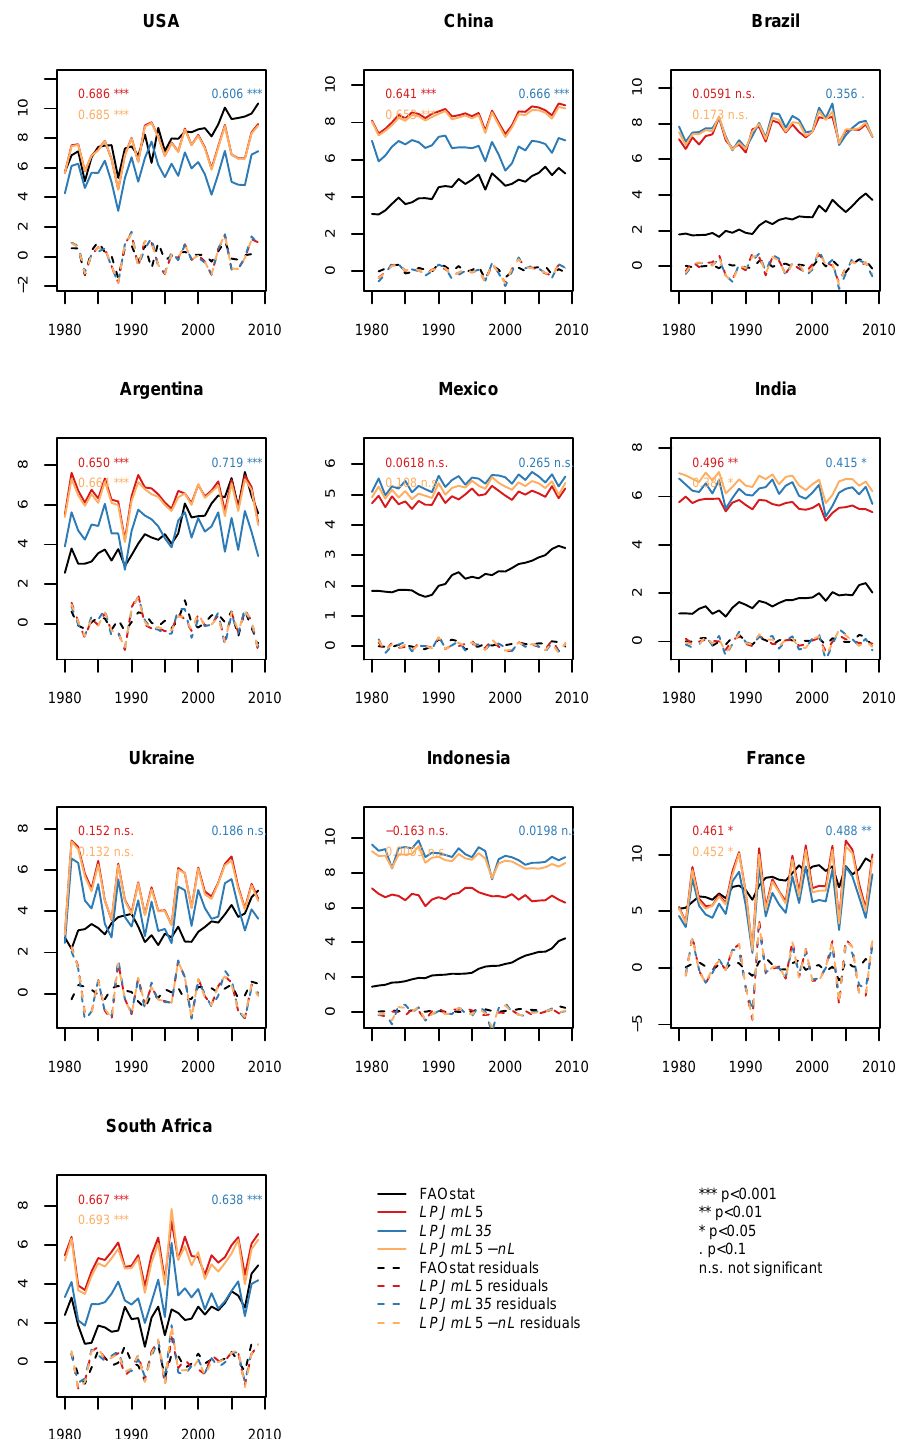
Figure 10. Maize yield simulations (in tons of fresh matter (FM) ha − 1 ) for the 10 top-producing countries for the carbon-only LPJmL3.5 version ( LPJmL35 ), the version with N limitation ( LPJmL5 ), and with unlimited N supply ( LPJmL5-nL ). The residuals plotted are the detrended observed and simulated